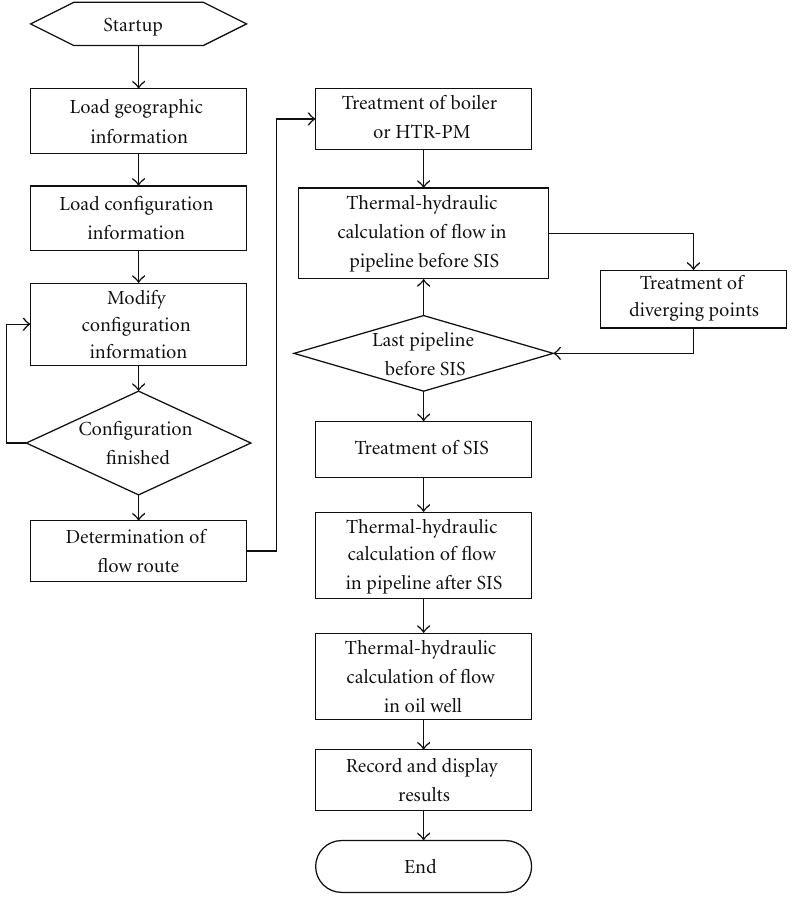
Figure 6: Flow chart of the